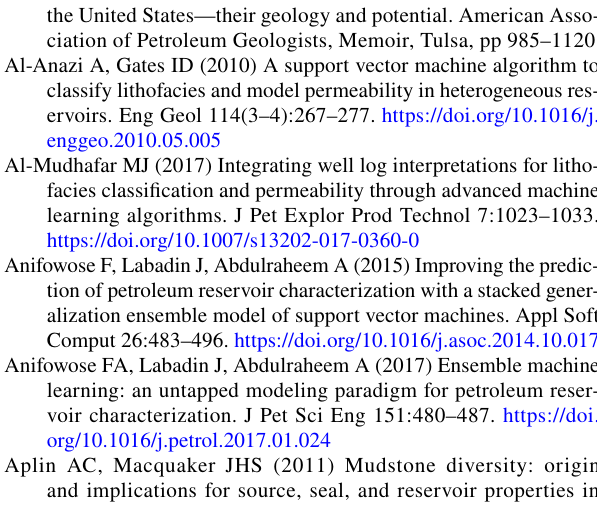
Kindly refer user guide of Scikit-learn Python toolbox for detailed explanation of